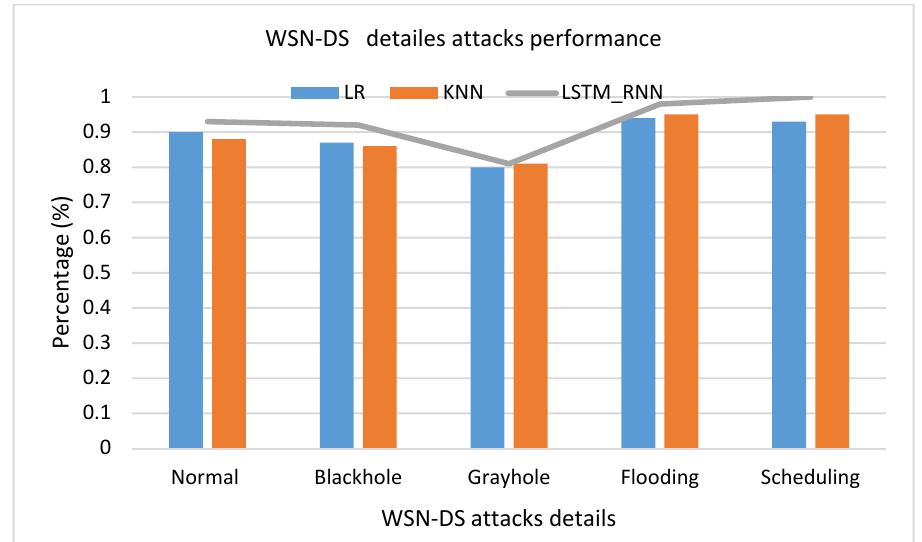
Figure 23. WSN-DS detailed attacks classification accuracy comparison.